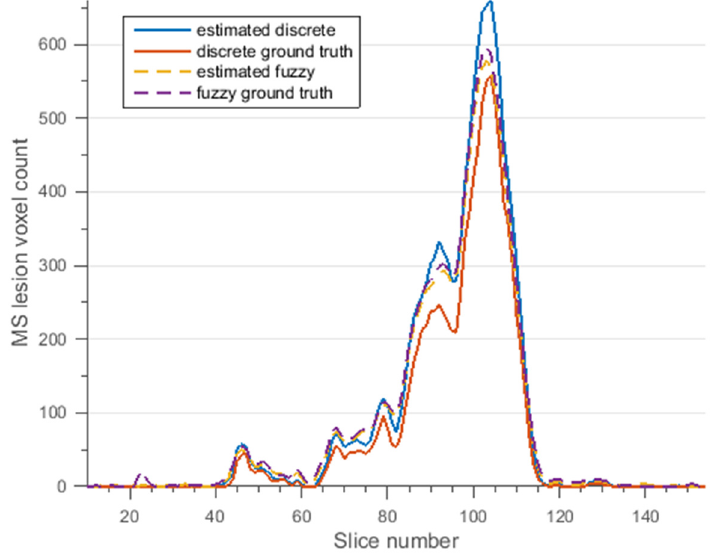
Figure 15. MS lesion cluster counts from discrete (solid) and fuzzy (dashed) estimates compared to ground truths, slice by slice, in the ROI of the brain data with severe MS